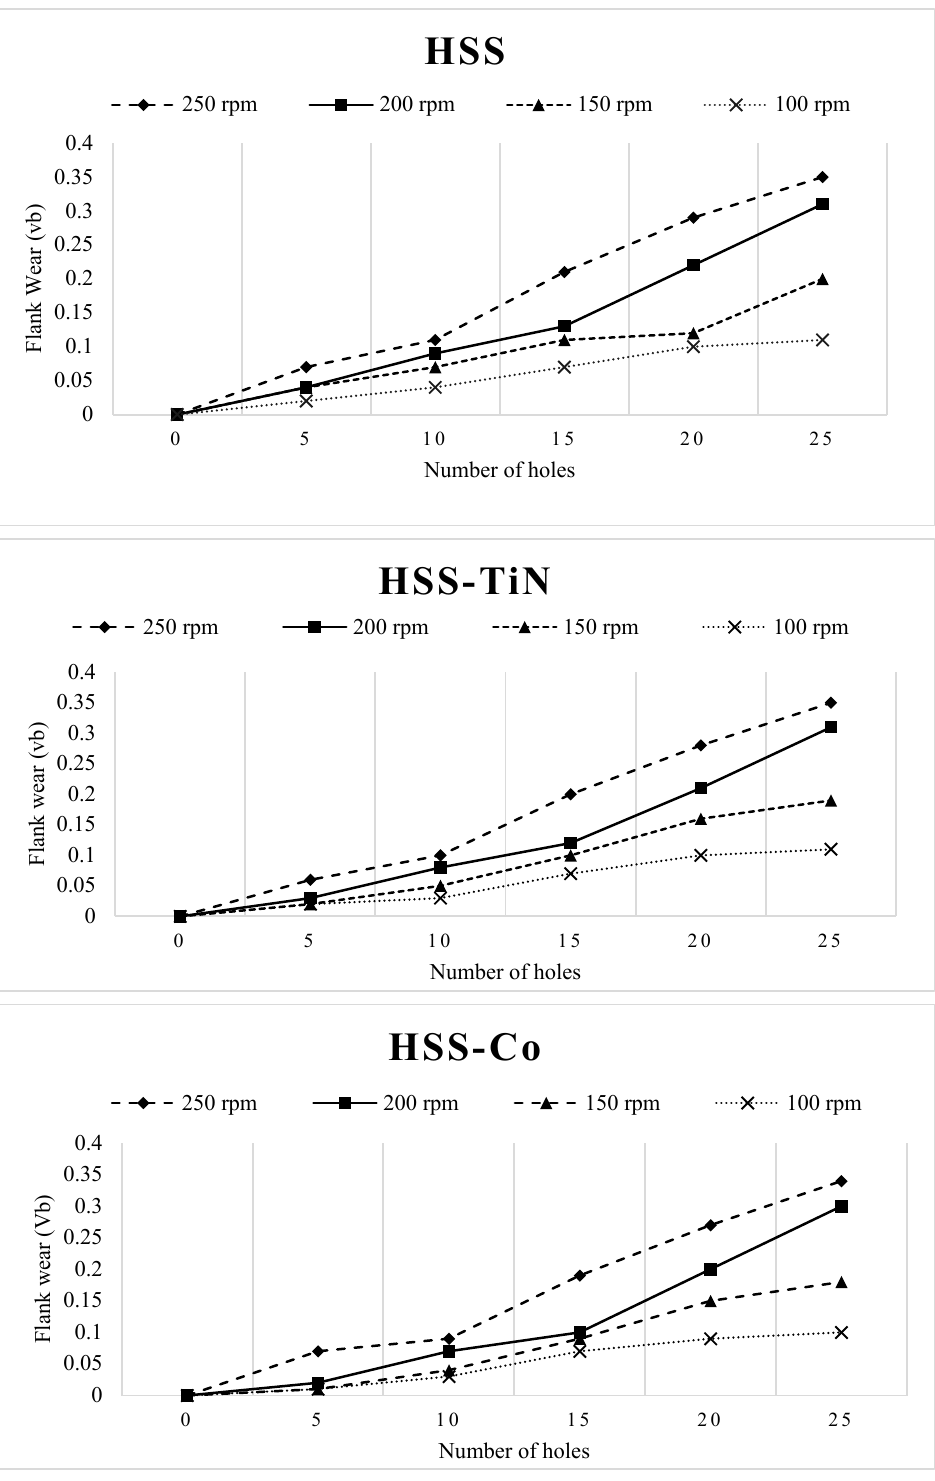
Figure 7. Comparison of flank wear of HSS, HSS-TiN, and HSS-Co at various spindle speeds. For the HSS-Co cutting tool, it took the same 25 holes and 15 holes to reach Vb max at 100 and 150 rpm, respectively. Nevertheless, the performance of HSS-Co helped the increase at 200 rpm. The Vb max was recorded at the same 15th hole when 200 rpm was applied to the drilling process. Similarly, only 10 holes can be drilled using HSS-Co with 250 rpm before it reaches Vb max .